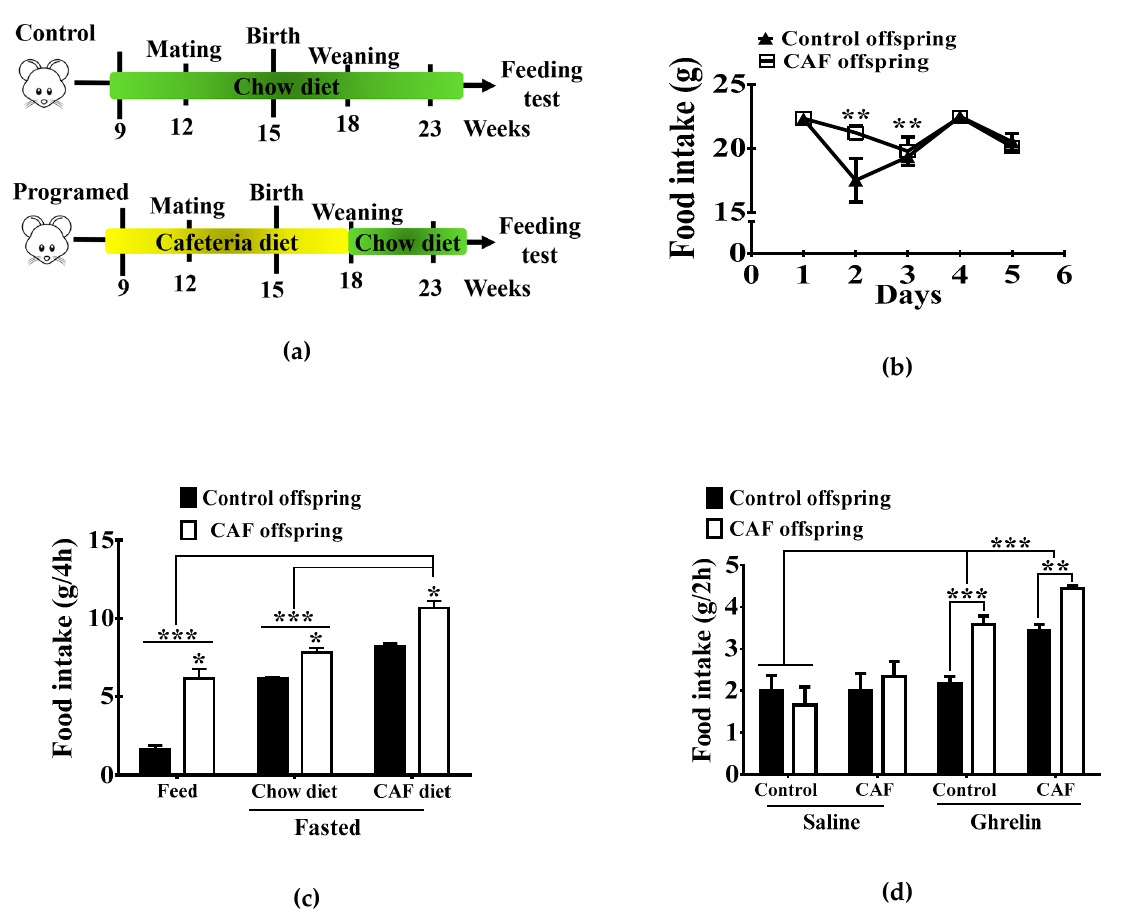
Figure 1. E ff ect of maternal nutritional programming on food intake in male o ff spring. ( a ) Maternal programing was performed by exposing Chow or CAF diet for nine weeks including pre-pregnancy, pregnancy and lactation. After weaning the o ff spring of both (CAF and Chow diets) was exposed to Chow diet for 5 weeks, by two months of age (week 23) we performed the feeding test. ( b ) Daily food intake by both Chow o ff spring and CAF diet o ff spring. ( c ) Chow and CAF diet consumption during 4 h in o ff spring after fasting for 16 h and refeeding. ( d ) Food intake for 2 h after administration with ghrelin 0.2 µ g / Kg SC. (control diet group n = 10–12; cafeteria diet (CAF) group n = 10–12; the graphs show normalized data of the mean ± S.E.M. Two-way ANOVA followed by Tukey multiple comparation test; * p < 0.05, ** p < 0.01, *** p <